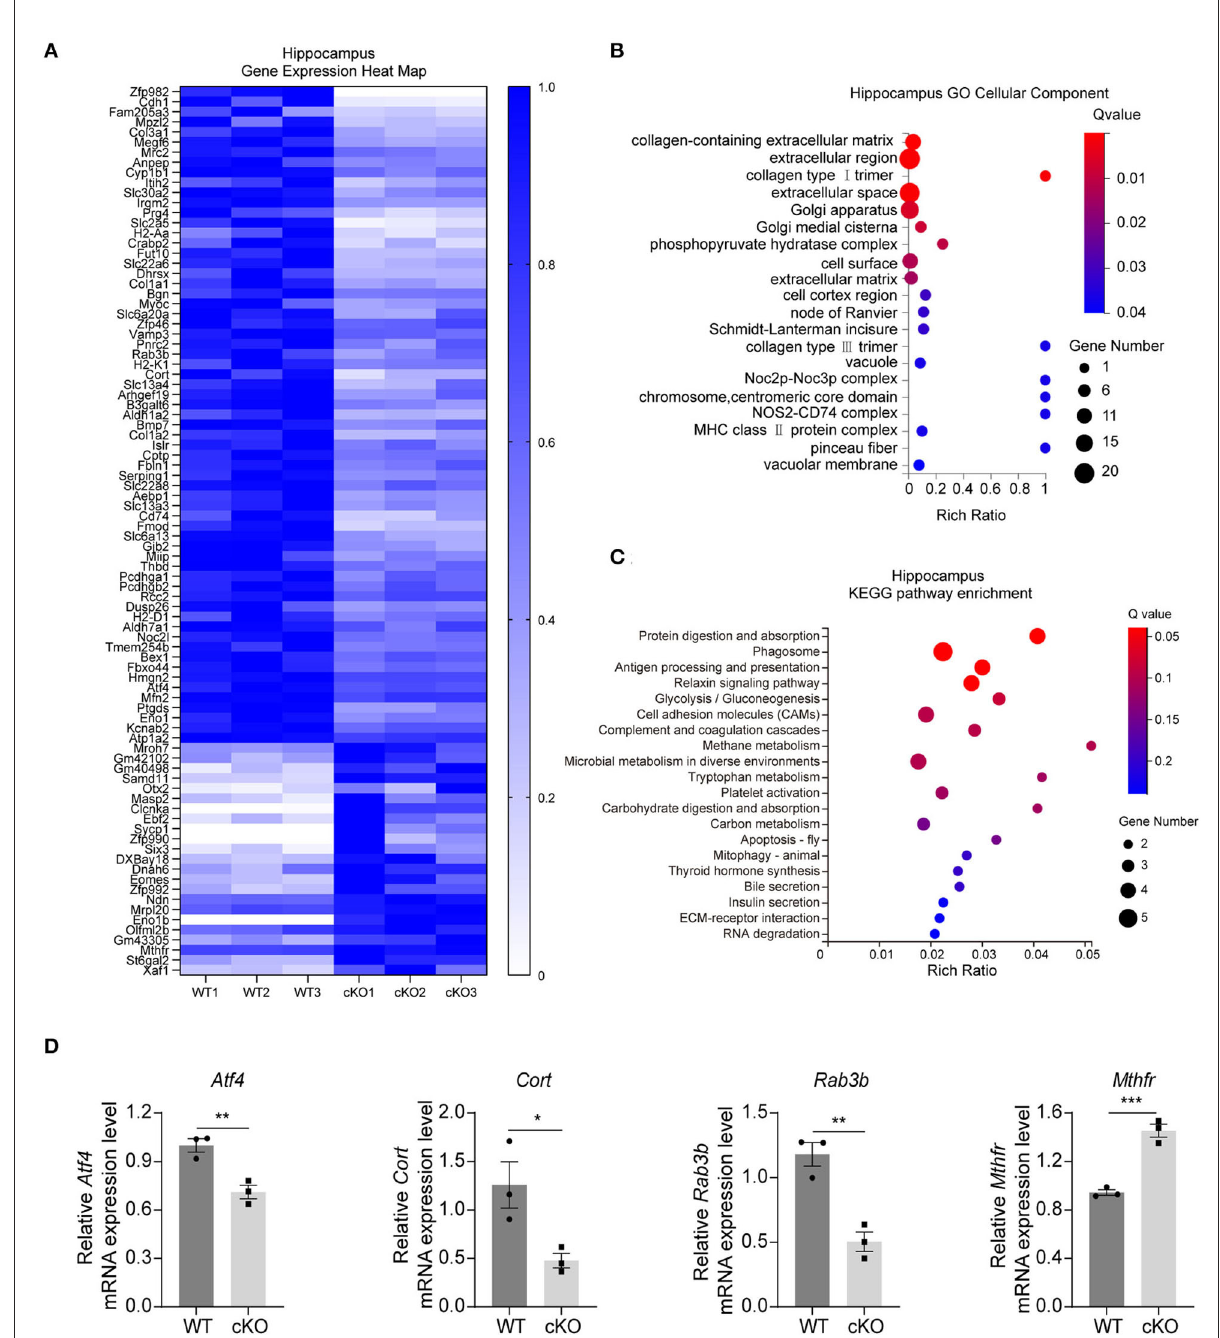
FIGURE2 Changes in signaling pathways and expression profiles of genes in the hippocampus of the MAD2B cKO mice. (A) Heat map of DEGs in the hippocampus; the deeper the purple, the higher the expression. (B) GO analysis of cellular components of DEGs in the hippocampus, n = 3, p < 0.05. The size of the bubble indicates the gene number, the color depth indicates the Q-value, and the rich ratio indicates the gene number/the total gene number in the y-axis item. (C) KEGG pathway enrichment analysis of DEGs in the hippocampus, n = 3, p < 0.05. The size of the bubble indicates the gene number, the color depth indicates the Q-value, and the rich ratio indicates the gene number/the total gene number in the y-axis item. (D) qRT-PCR identification of DEGs in the hippocampus ( Atf4 p = 0.0079, t = 4.973; Cort p = 0.0354, t = 3.125; Rab3b p = 0.0046, t = 5.712; and Mthfr p = 0.0009, t = 8.831, unpaired two-tailed t- test) n = 3, * p < 0.05, ** p < 0.01, *** p < 0.001. All data are displayed as means ±